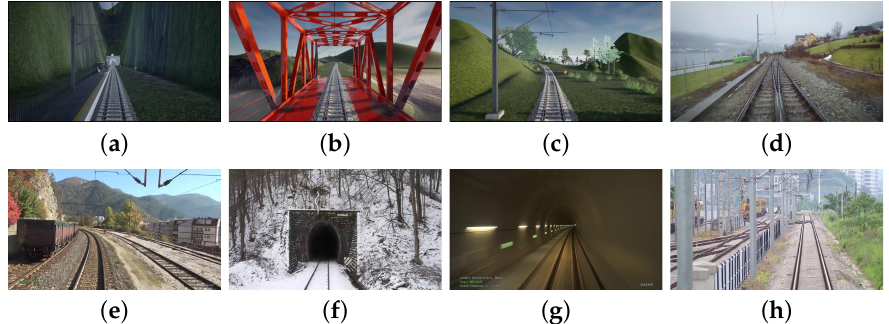
Figure 8. Some representative samples in the dataset. ( a – c ) correspond to the simulated data in our dataset, ( d – g ) correspond to the network crawling data in our dataset and they, respectively, represent rainy, sunny, snowy days and a scene in the tunnel. ( h ) corresponds to the collected data.